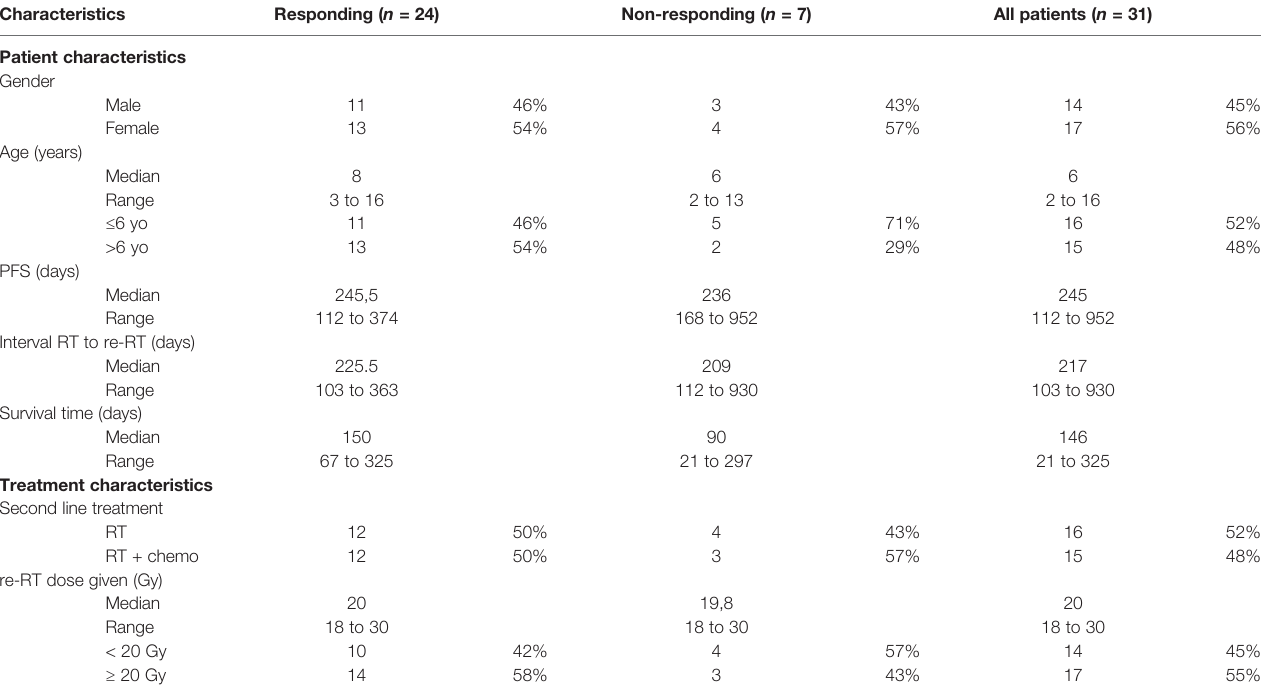
TABLE 1 | Demographic and disease characteristics of patients grouped according to the clinical response to re-RT.